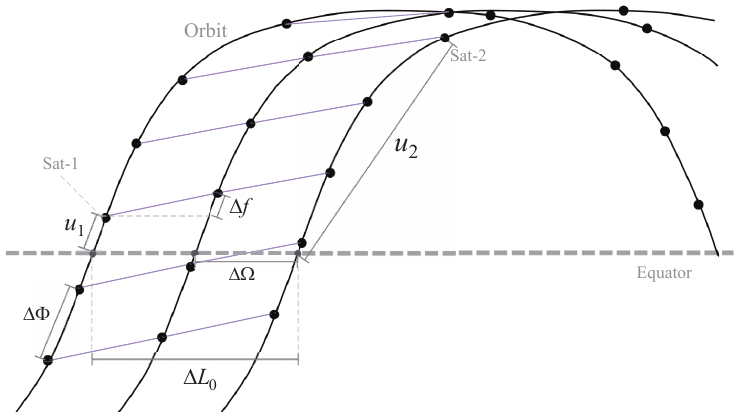
Figure 2. A partial constellation diagram marked by various modeling